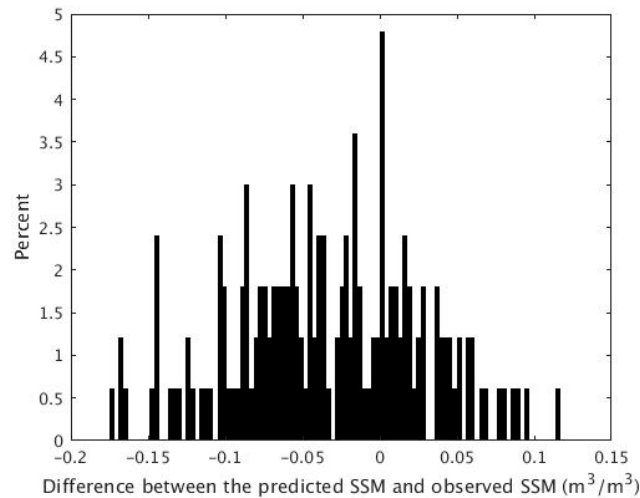
Figure 6. Histogram of the difference between predicted SSM and observed SSM.